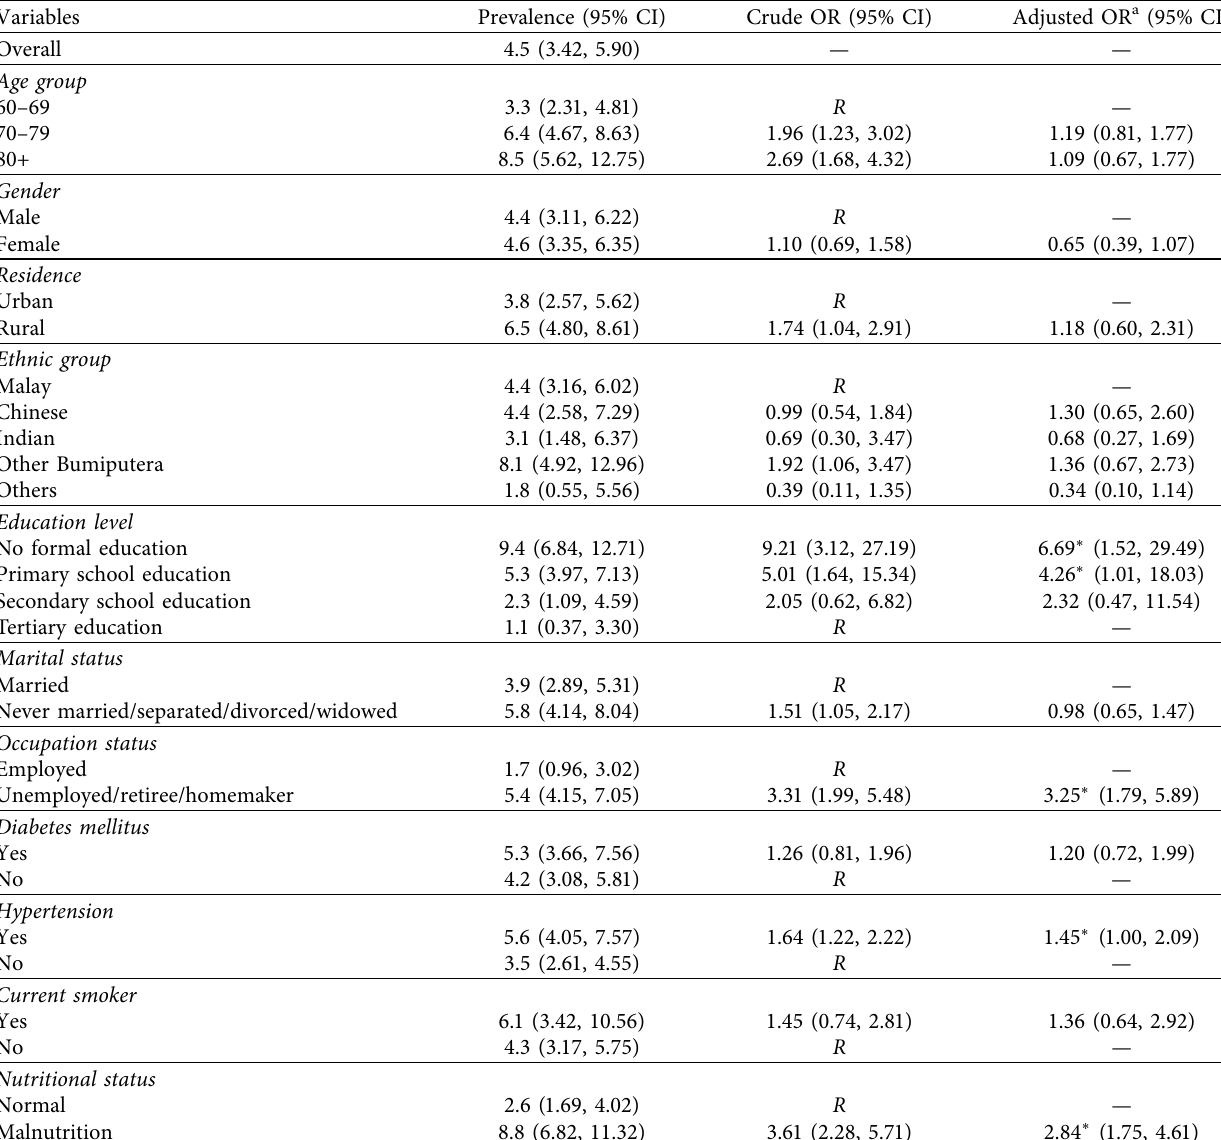
Table 3: Prevalence and associated factors of vision disability among the elderly (60 years and above) in